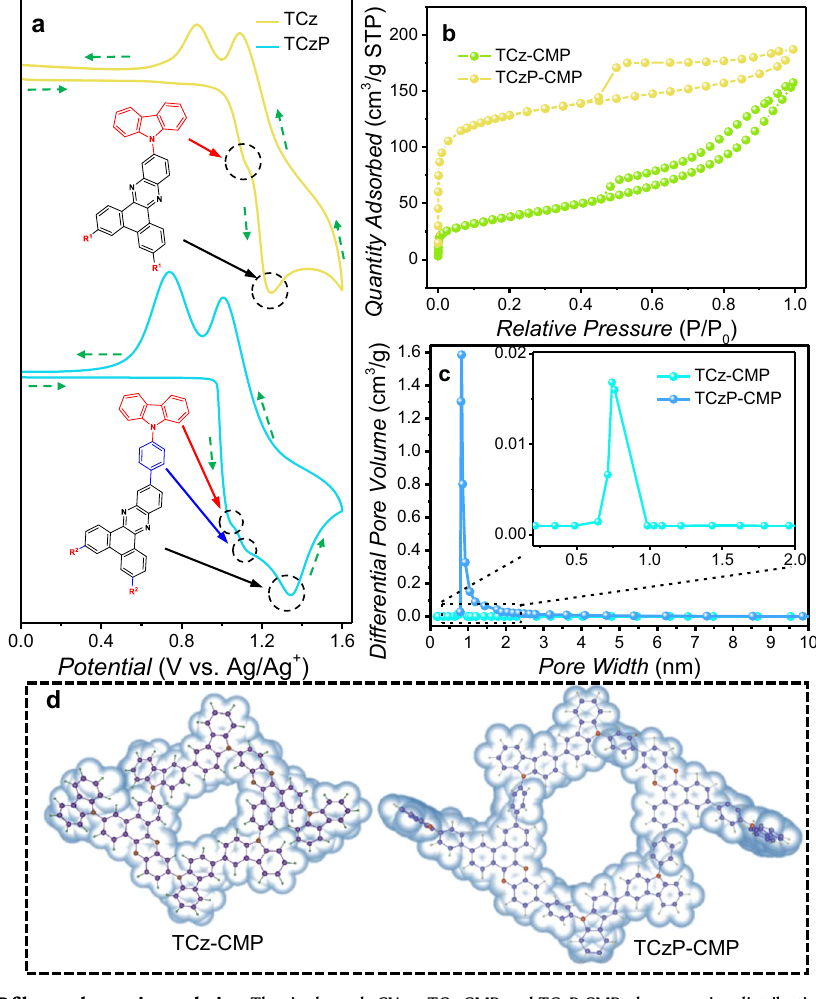
TCz-CMP and TCzP-CMP; the pore size distribution was calculated from the cor- responding N 2 adsorption isotherm using the Horvath-Kawazoe method. d The optimal con fi guration of TCz (left) and TCzP (right) calculated by